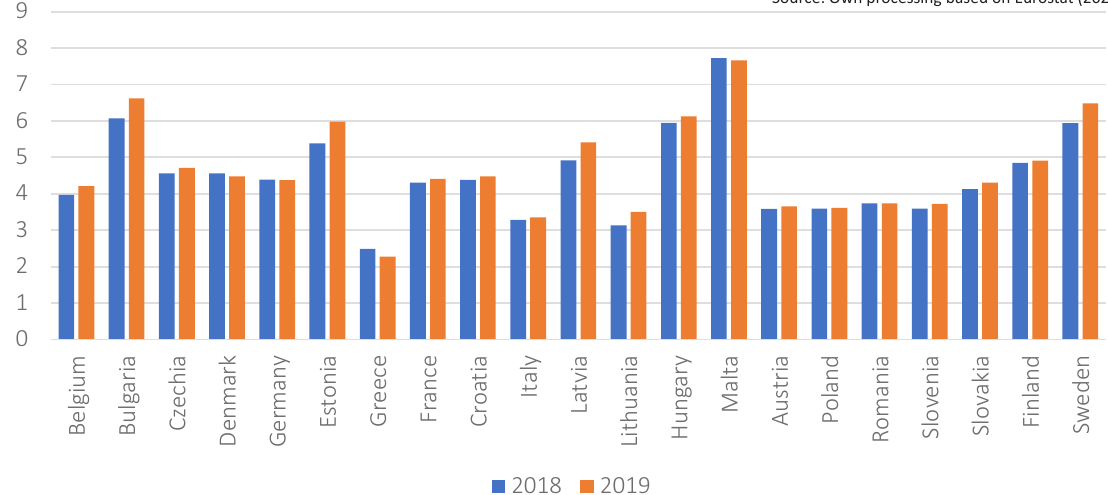
Figure 1. ICT share as % of GDP in EU